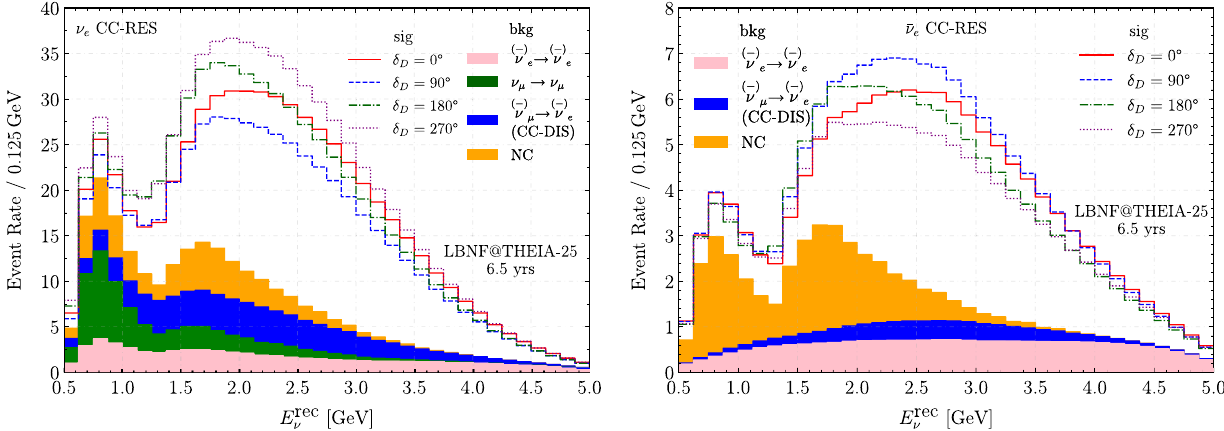
Fig. 10 The event spectra of CC-RES signal and its background at the THEIA-25 detector with LBNF neutrino (left) and anti-neutrino (right) beams. Four lines are used for δ D = 0 ◦ (solid red line), δ D = 90 ◦ (dashed blue line), δ D = 180 ◦ (dot-dashed green line) and δ D = 270 ◦